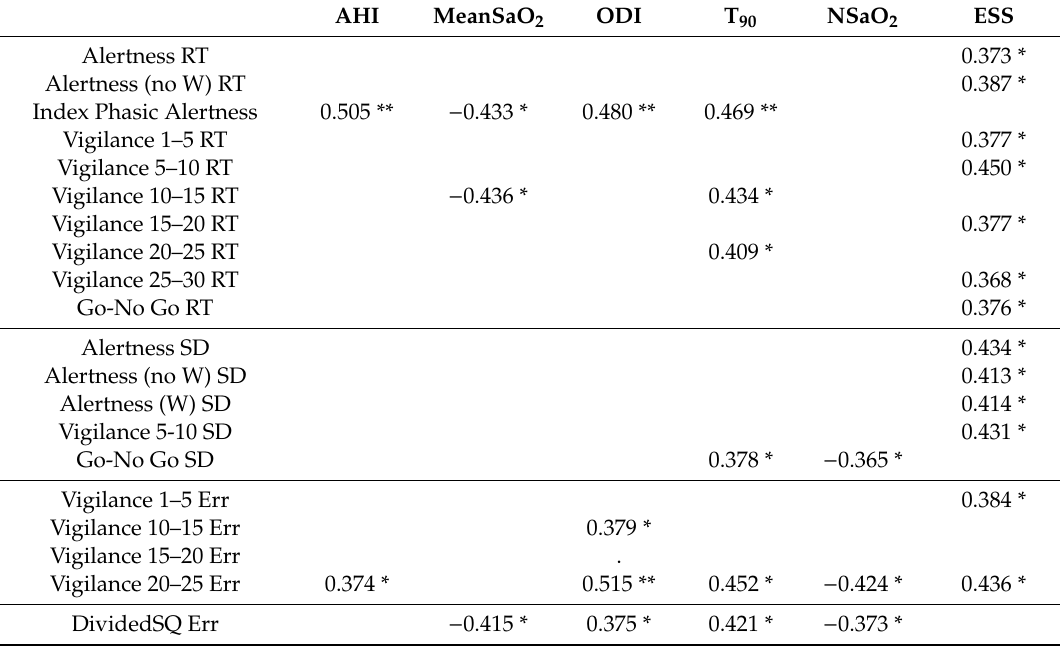
Table 7. Significant correlations (Pearson) between apnea-hypopnea index, oxygenation parameters, Epworth Sleepiness Scale, and Test for Attention Performance scores for the OSA patients. AHI MeanSaO 2 ODI T 90 NSaO